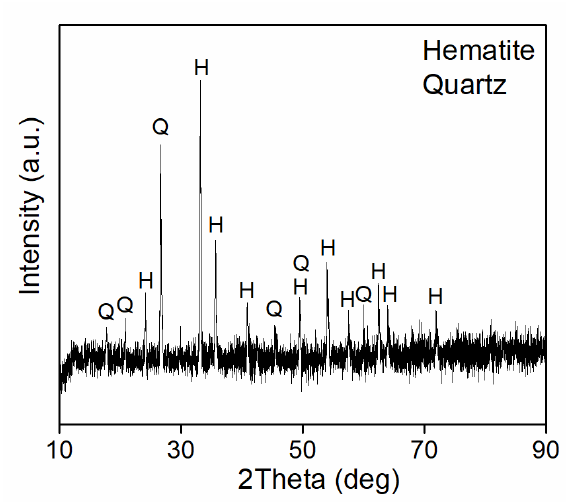
Figure A5. XRD result for natural hematite. Hematite (H) and quartz (Q) were identified.